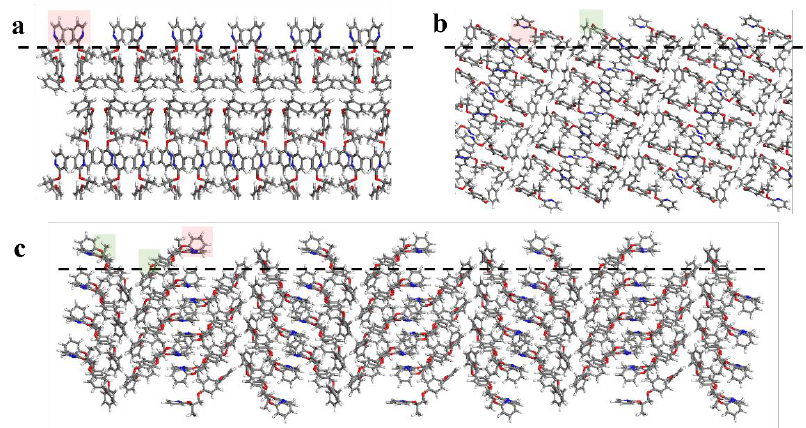
Figure 9. Surface structure of morphologically important (MI) faces of pyriproxyfen. ( a ) (002) face; ( b ) (102) face; ( c ) (111) face. The red block shows the position of H4 on pyriproxyfen, and the green block shows the position of O3 on pyriproxyfen.